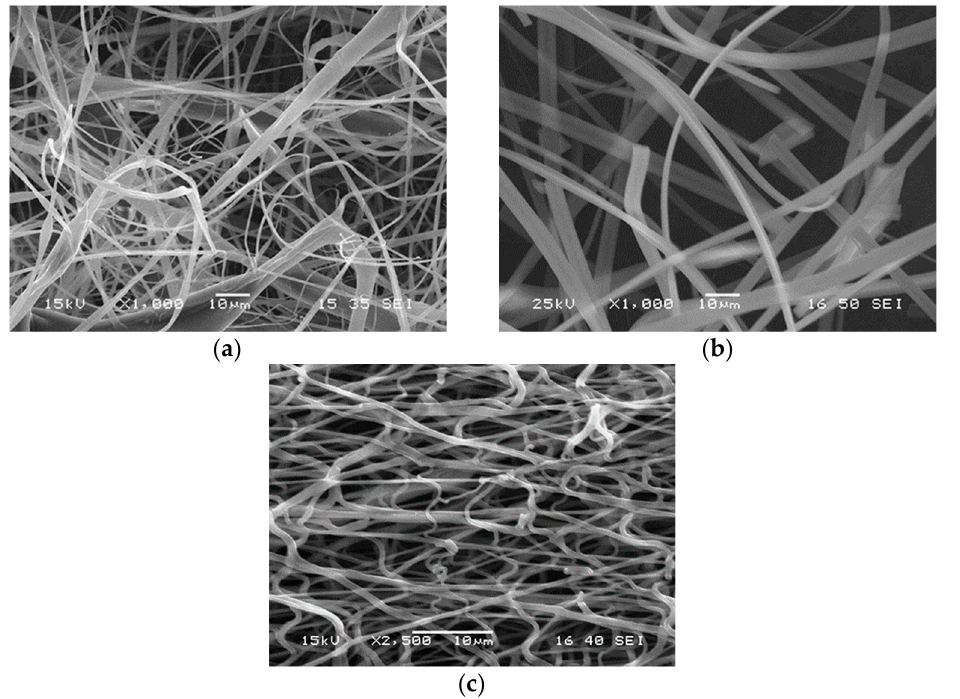
Figure 2. SEM micrographs recorded on electrospun fibers containing 20 wt% valsartan in various matrix polymers; ( a ) HPMC, ( b ) PVP, ( c ) PVA. matrix polymers; ( a ) HPMC, ( b ) PVP, ( c )